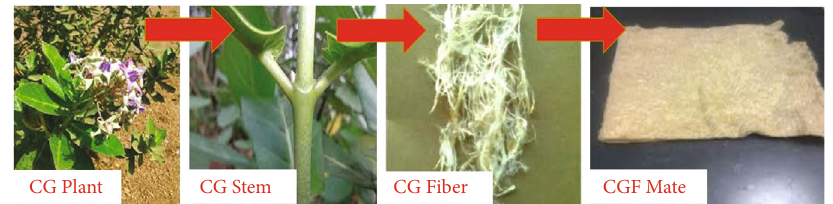
Figure 2: Extraction of CGF mate from CG plant. Table 1: Constrains and their stages for composite.